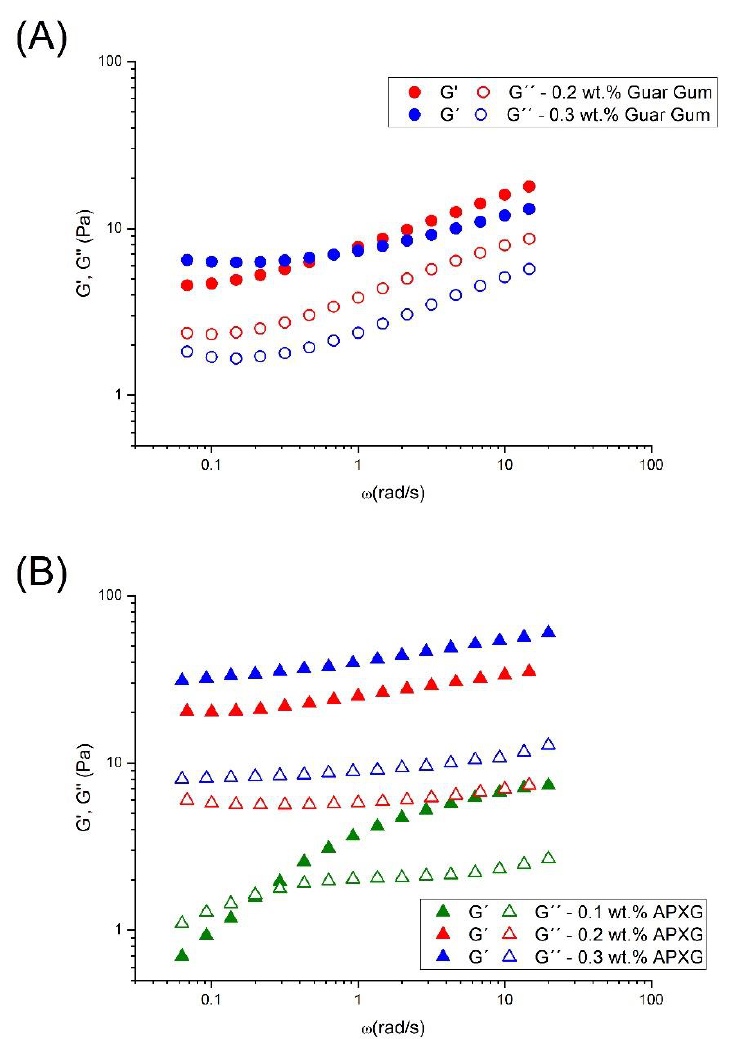
Figure 3. Frequency sweeps for linseed oil emulsions as a function of gum concentration for systems formulated with ( A ) guar gum and ( B ) Advanced Performance xanthan gum.